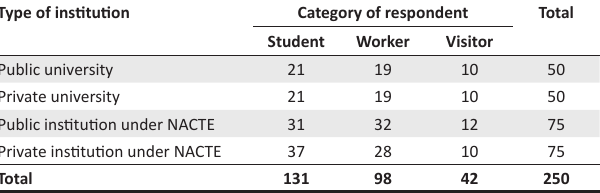
TABLE 4: The number and type of respondents from each institution